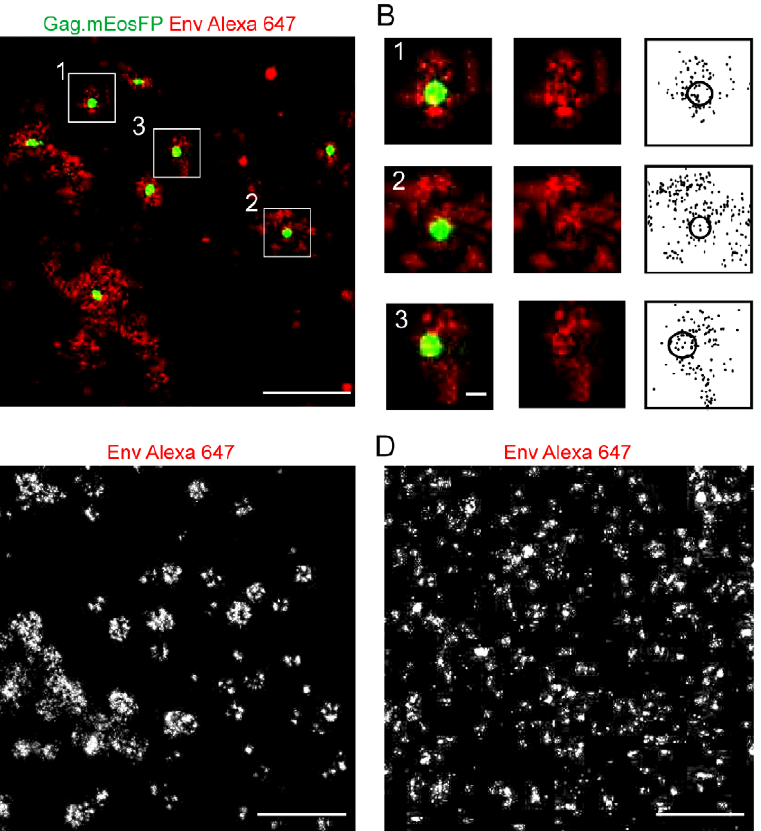
Figure 3. Comparative analysis of Env(wt) distribution expressed in the viral context or alone. ( A, B ) Distribution of HIV-1 Gag and Env at the plasma membrane of HeLa cells transfected with equimolar amounts of pCHIV and pCHIV mEosFP . Unfixed cells were stained by indirect immunofluorescence using Fab 2G12 and Fab goat anti-human Alexa Fluor 647, fixed, and subjected to dual-color super-resolution microscopy as described in Materials and Methods. ( A ) Region from the plasma membrane of a representative cell, showing the superposition of a PALM image for Gag.mEosFP (green) and the corresponding dSTORM image of Env stained with Alexa Fluor 647 (red), respectively. Scale bar corresponds to 1 m m. ( B ) Enlargement of three individual assembly sites from the boxed regions indicated in (A). The figure shows merged super-resolution images (left panels), the dSTORM Env Alexa Fluor 647 image (middle panels) and individual Alexa Fluor 647 localizations from all images recorded in the defined area as black dots, with a black circle representing the rims of the Gag cluster (right panels), respectively. Scale bar corresponds to 100 nm. ( C, D ) Env distribution patterns in the presence (C) and absence (D) of other HIV-1 derived proteins. HeLa cells were transfected with equimolar amounts of pCHIV and pCHIV mEosFP ( C ) or with pEnv(wt) ( D ), respectively. Unfixed cells were stained with 2G12 Fab and Alexa Fluor 647 Fab, fixed, and visualized by dual-color super-resolution microscopy as described in Materials and Methods. Scale bars represent 1 m m.